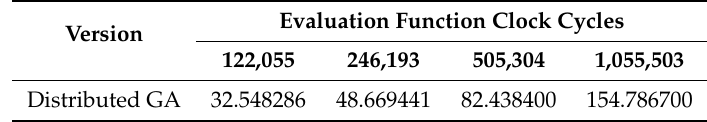
Table 12. Processing time (in seconds) distributed GA (2 nodes) running at 8